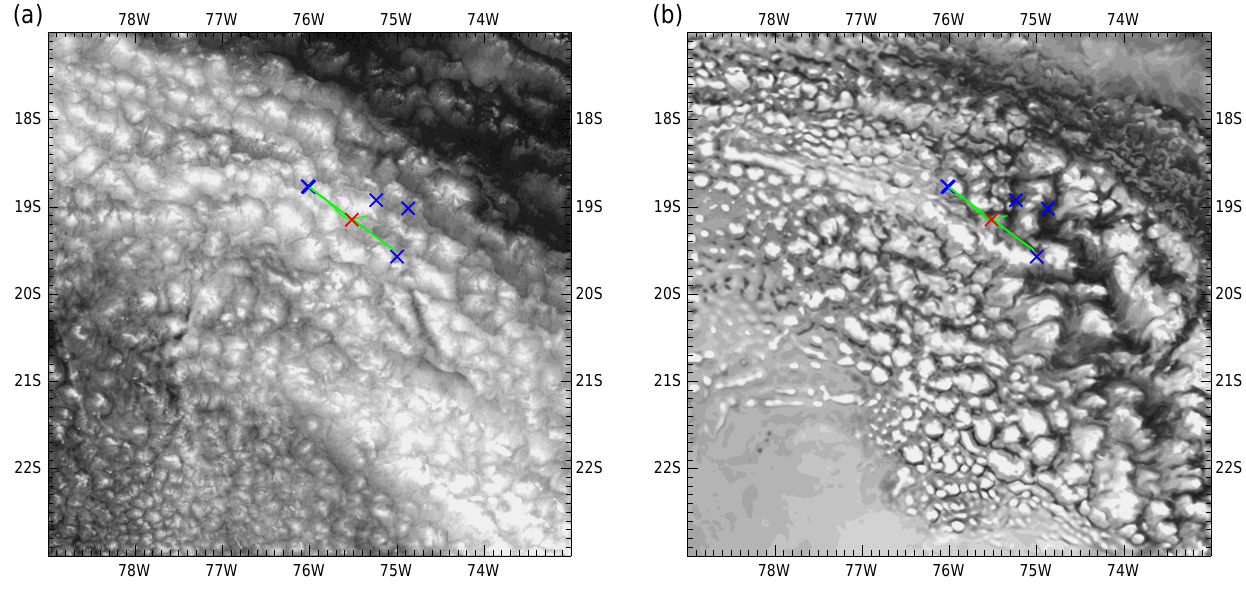
Fig. 3. (a) Visible satellite image from GOES-10 at 15:00 UTC on 12 November 2008. (b) MetUM simulated short-wave upwelling radiation at top-of-atmosphere, from the 1 km control simulation at the same time. The red cross shows the position of the Ron Brown at this time, with profile ascent/descent locations (blue) and straight and level runs (green) of the BAe-146 near this time.